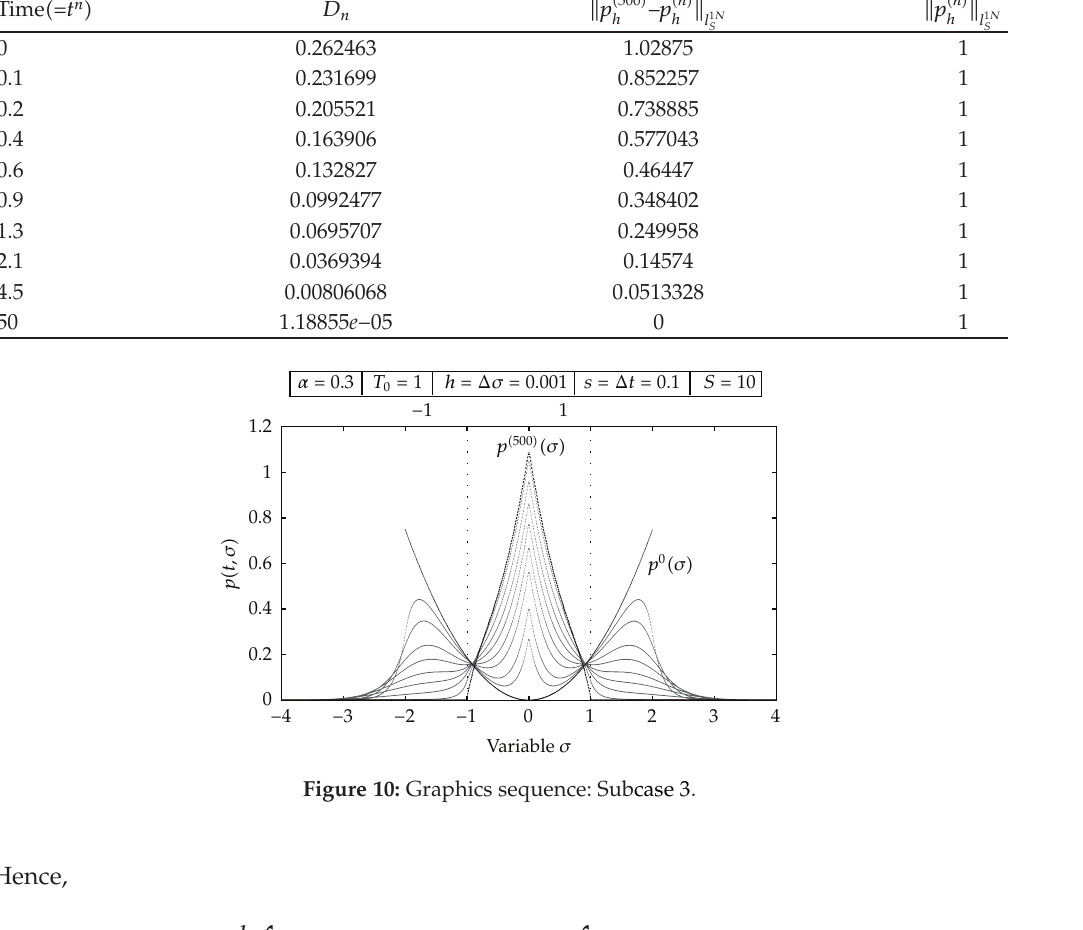
Table 8: Numerical results: Subcase 3.